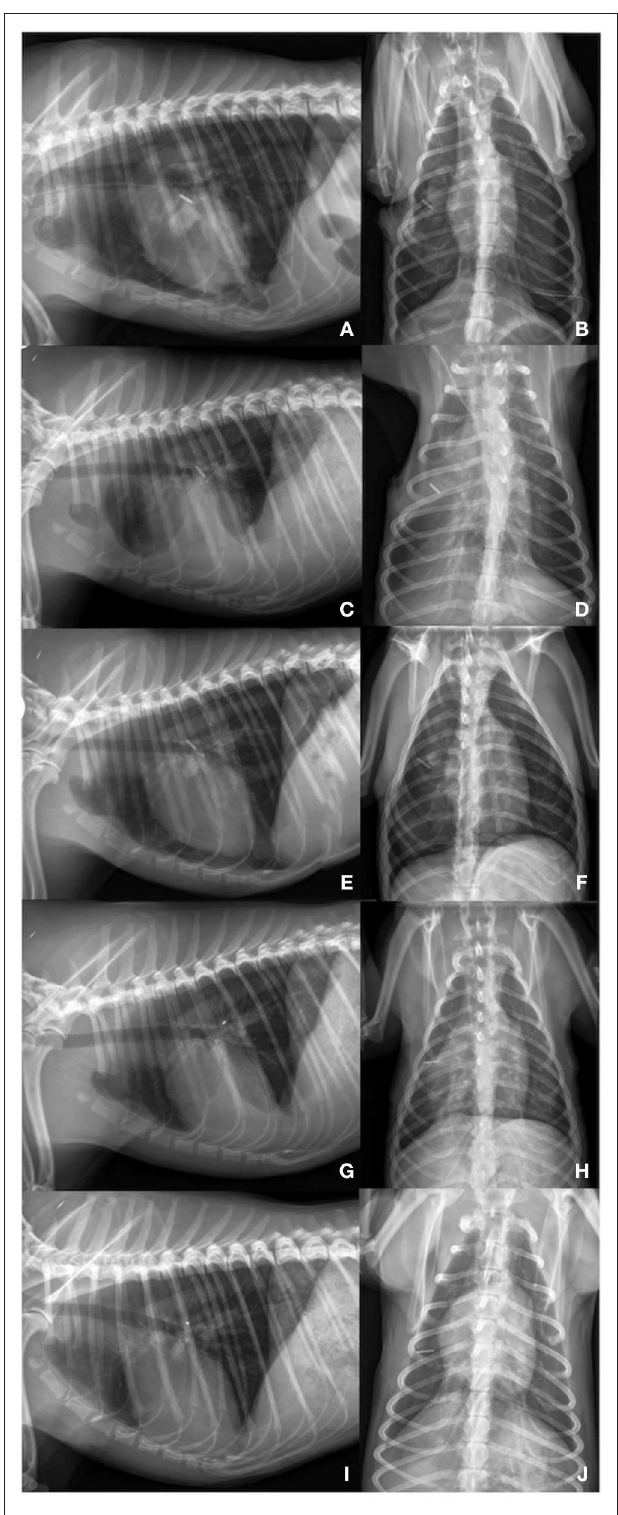
FIGURE 3 | (A,B) Day 6: Lateral left sided and ventrodorsal thoracic radiograph view: Lung lobes re-expanded to 80% on the left and right